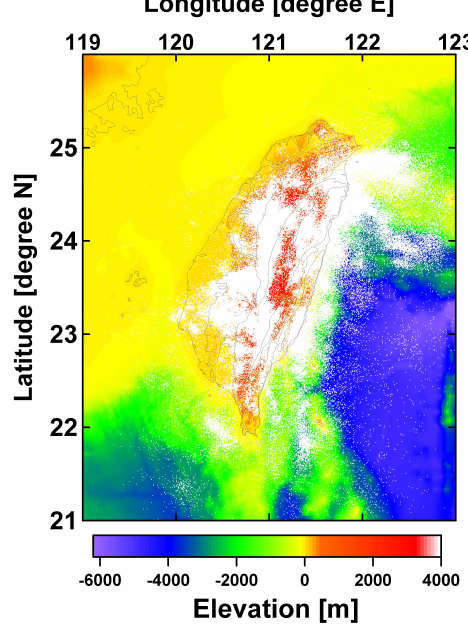
Fig. 1. Spatial distribution of the Taiwanese seismicity from 1 Jan- uary 1990 to 30 November 2007. The data were extracted from the Central Weather Bureau